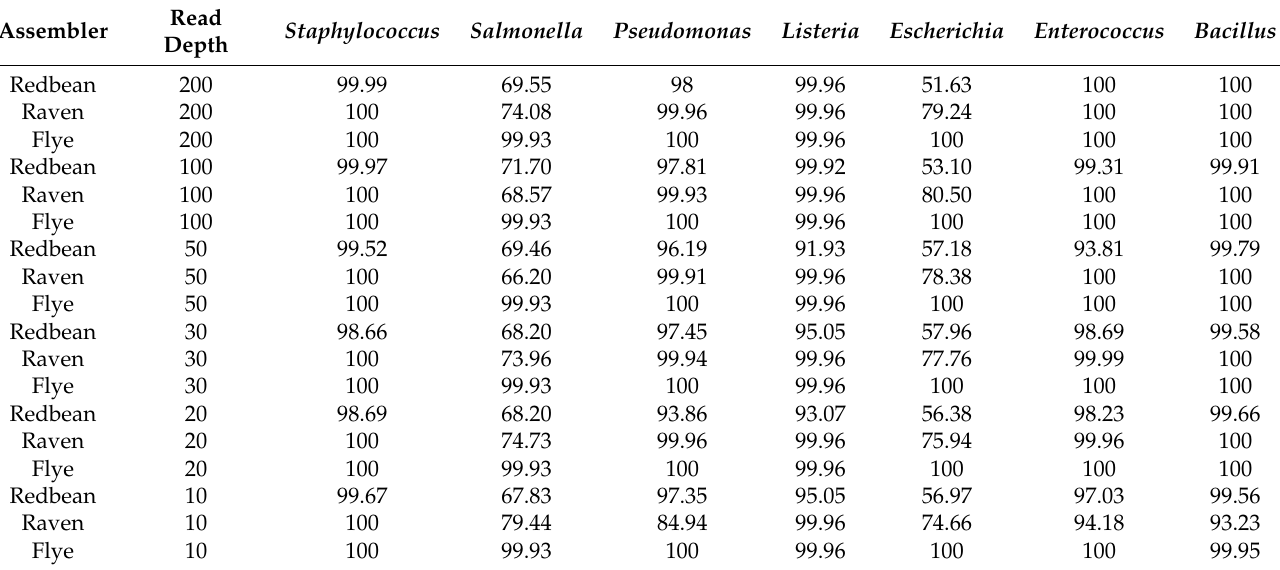
Table A1. Median genome fractions for all community members.